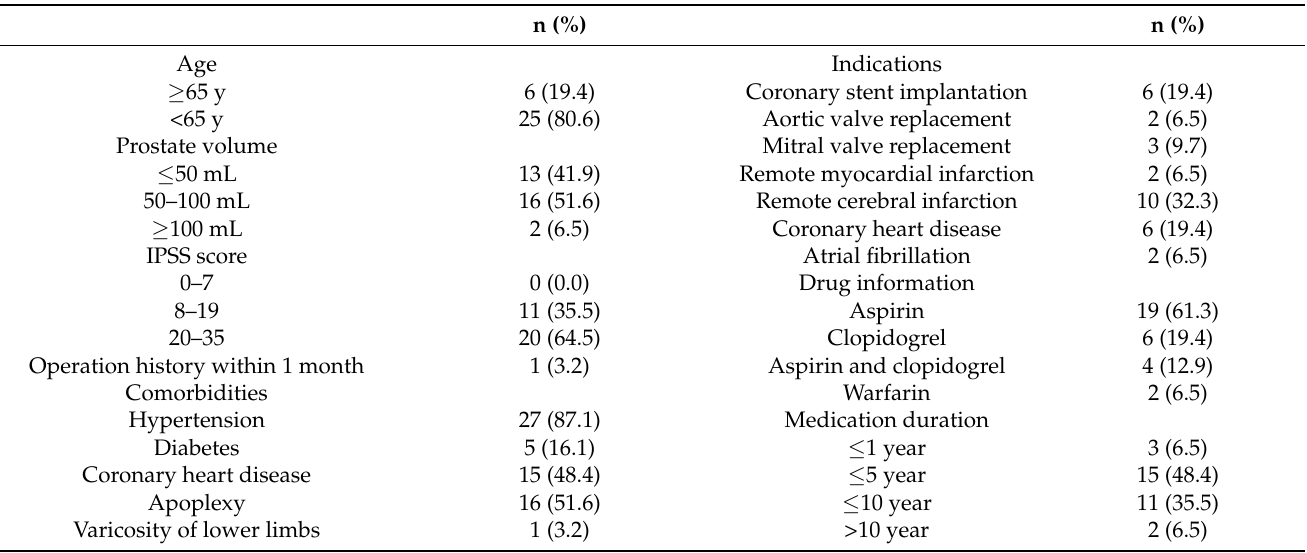
Table 1. Baseline information of patients and types, indications, and administration duration of antithrombotic drugs (n = 31).